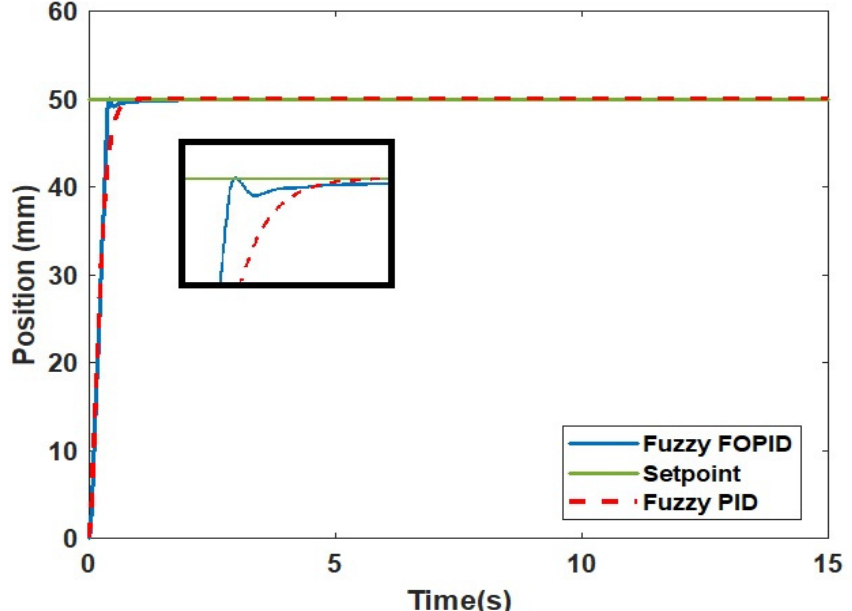
Figure 17. Fuzzy FOPID and fuzzy PID simulation performances (50 mm fixed position).